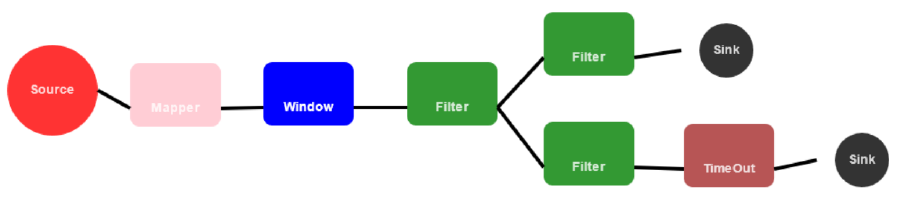
Figure 4. Streaming MASSIF pipeline to calculate the COVID-19 aerosol transmission risk